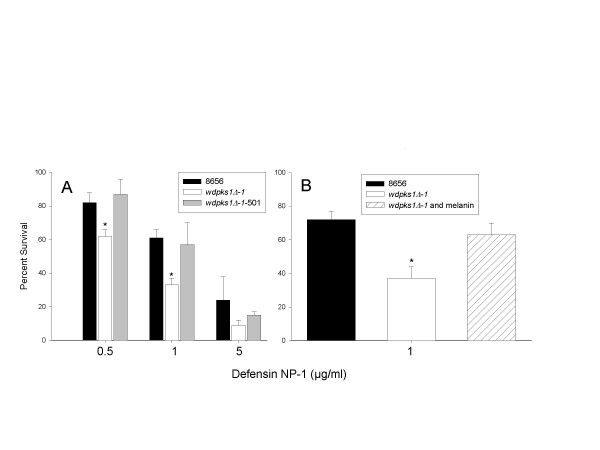
Defensin NP-1 time-kill assay. A] The rates of survival of strains 8656, wdpks1Δ-1, and wdpks1Δ-1-501 yeast cells grown for 7 days in YPD medium at 37°C after exposure to various concentrations of NP-1 for 30 min compared to those of fungal cells incubated in PBS. B] Survival of strain 8656 and wdpks1Δ-1 after exposure to 1 μg/ml of NP-1 and of wdpks1Δ-1 after exposure to 1 μg/ml NP-1 incubated with melanin particles derived from the gene deleted strain for 1 h prior to the use of the defensin solution in the assay. P value was calculated by comparing wdpks1Δ-1 cells treated with NP-1 with or without pre-incubation with melanin particles using the Student's t test. Values are averages of the standard errors of the means for three measurements. *, p < 0.01.